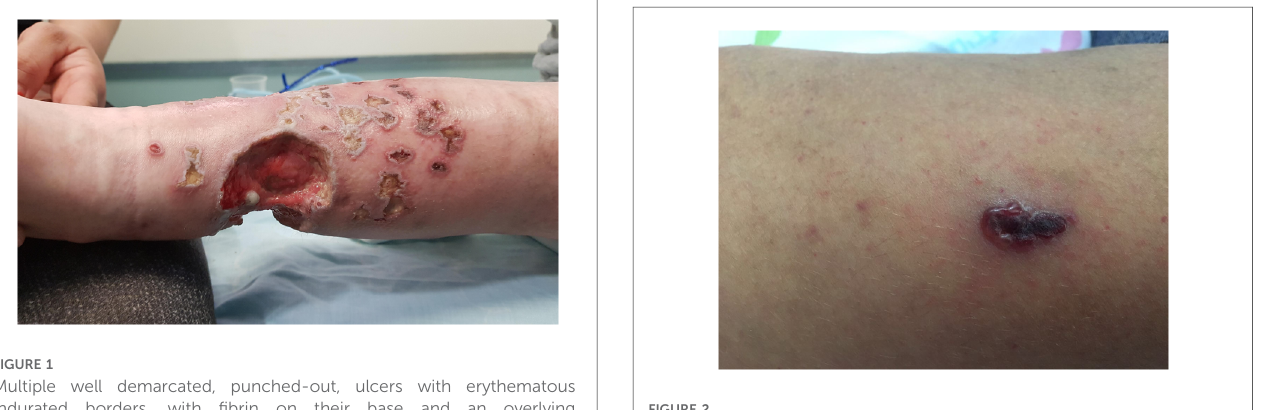
FIGURE 2 Hemorrhagic vesicle with a necrotic center on the arm of an 11-year-old girl with CVID, consistent with varicella-zoster virus infection. CVID, common variable immunode fi